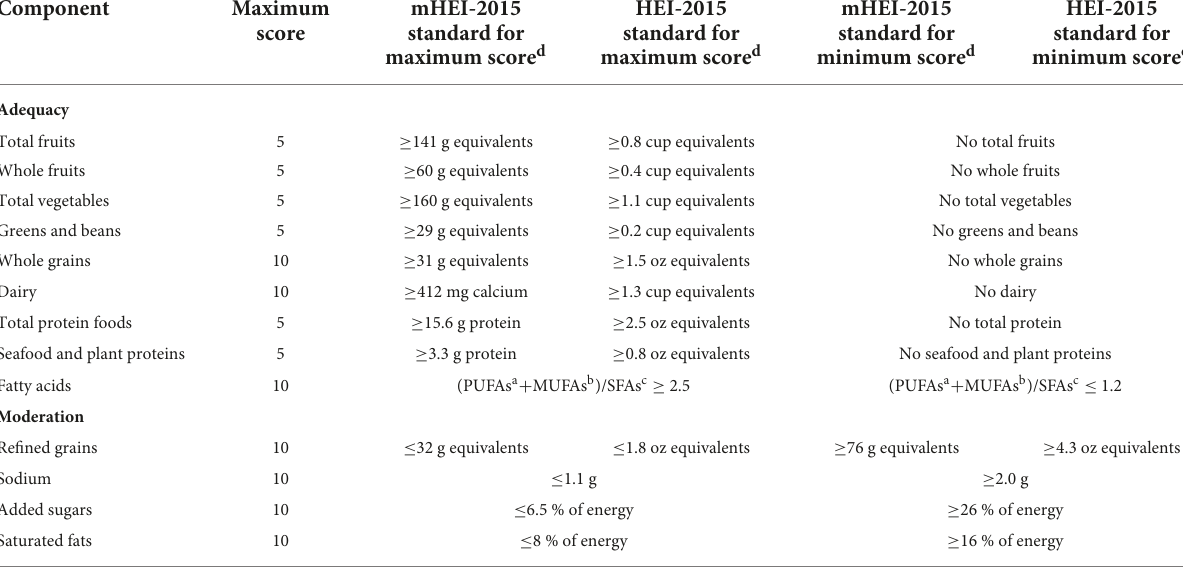
TABLE 2 mHEI-2015 and HEI-2015 (27) components, point values, and standards for scoring. Component